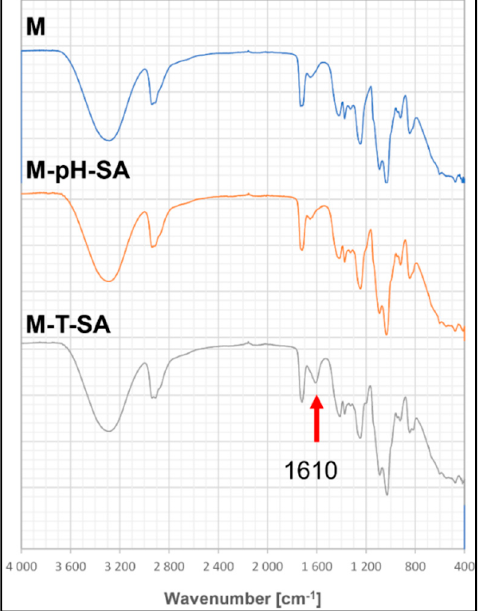
Figure 4. FT-IR spectra of the basic matrix (M), the system with a pH-sensitive nanocarrier and sal- icylic acid (M-pH-SA), and system with a thermosensitive nanocarrier and salicylic acid